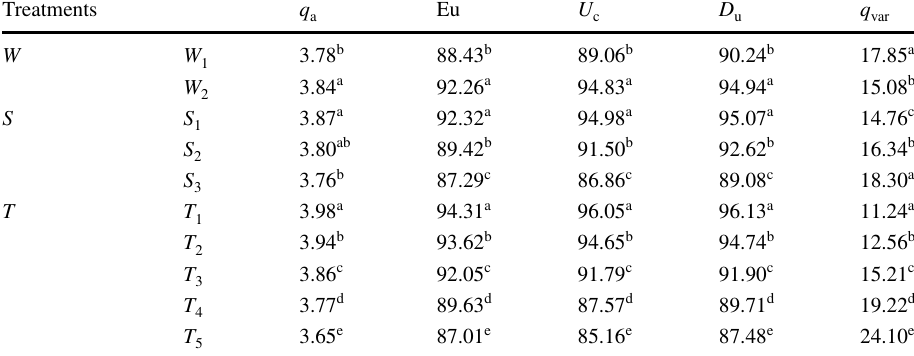
Table 6 Comparison of means of the parameters